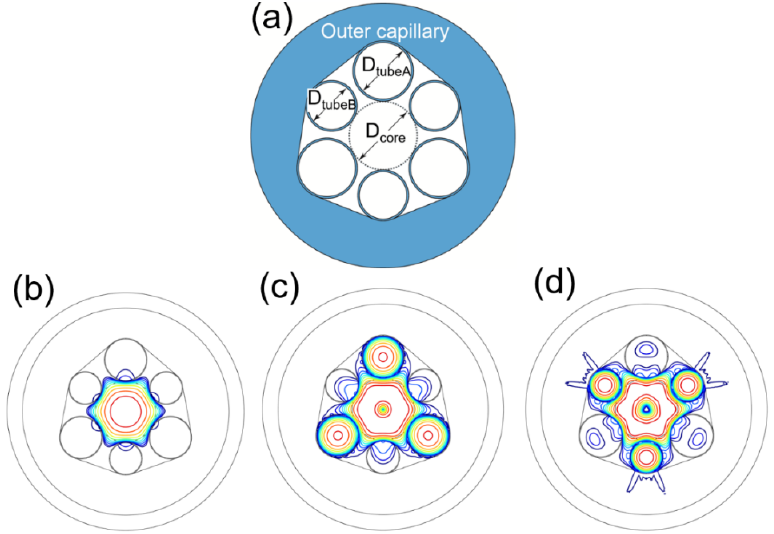
Figure 1. ( a ) Geometry of the six-tube negative curvature hollow-core fiber (NC-HCF) structure. ( b ) Simulated losses of the fundamental HE 11 mode and six higher-order modes (HOMs) (TE 01 , HE 21 , TM 01 , EH 11 , HE 31 , and HE 12 ) as a function of D tube / D core . ( c ) Three decibel (3-dB) contour lines of mode patterns: (1) LP 01 modes at D tube / D core = 0.68, point (1) in ( b ); (2) LP 11 modes at D tube / D core = 0.68, point (2) in ( b ); (3) LP 21 modes at D tube / D core = 0.52, point (3) in ( b ); (4) LP 21 modes at D tube / D core = 0.81, point (4) in ( b ); (5) LP 02 modes at D tube / D core = 0.49, point (5) in ( b ); and (6) LP 02 modes at D tube / D core = 0.77, point (6) in ( b ).